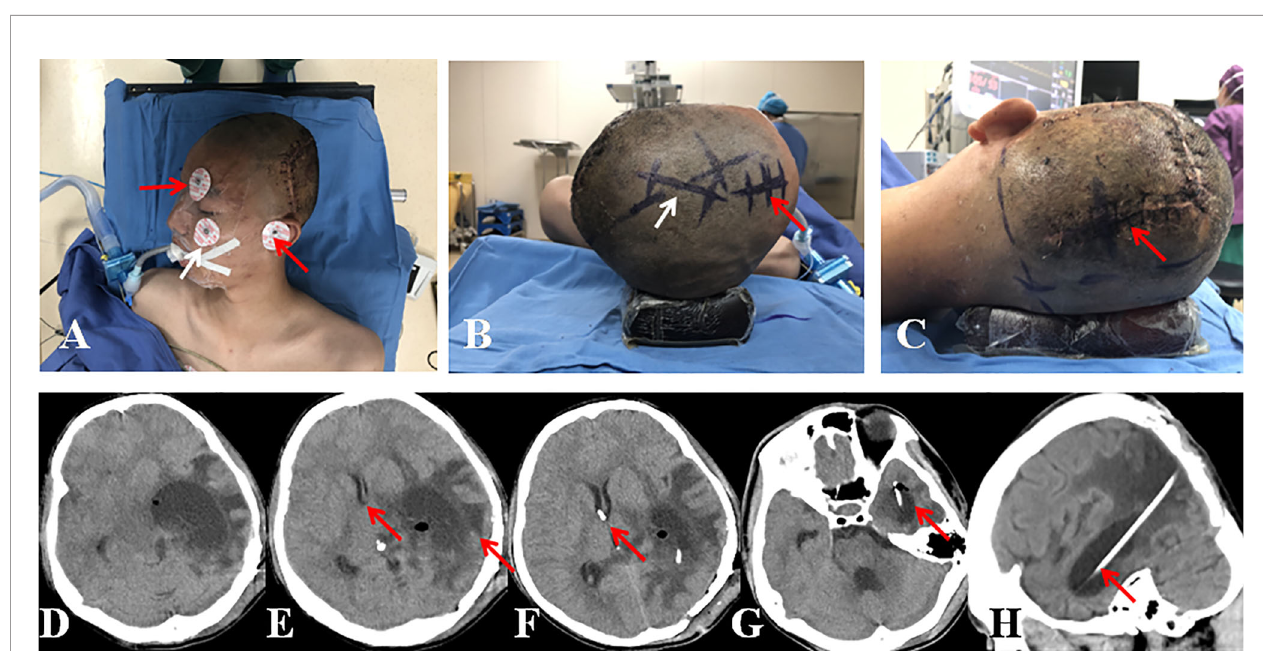
FIGURE 2 | (A) Patient position in superior view (red arrow, landmarks of medial canthus and tragus; white arrow, landmark of zygomatic process). (B) Patient position in rostral view (red arrow, skin incision for frontal burr hole; white arrow, skin incision for subcutaneous connection of the temporal and frontal catheters). (C) Patient position in left view (red arrow, skin incision for occipito-parietal burr hole). (D) CT scan showed severe dilation of the left temporal horn with compression of the brainstem. (E) CT scan showed prominent midline shift, PVBE, and displaced frontal horn (red arrows). (F, G) CT scan showed the suggested localization of catheter tips in the frontal and temporal horns (red arrows). (H) : CT scan showed the trajectory of temporal catheter (red arrow).